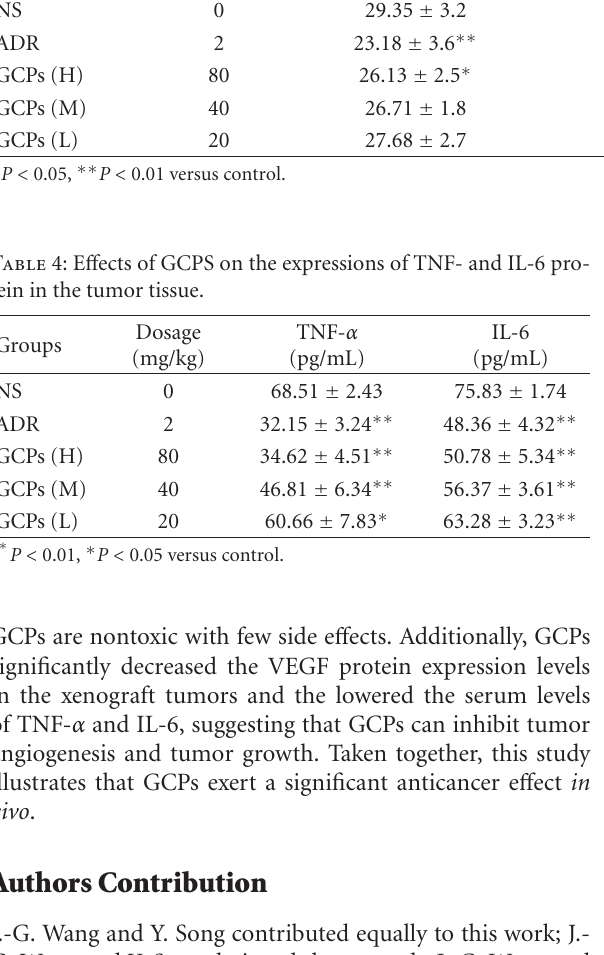
Table 3: Influence of Gecko on immune organs of transplanted H22 in mice (mean ± SD, n = 10). Groups